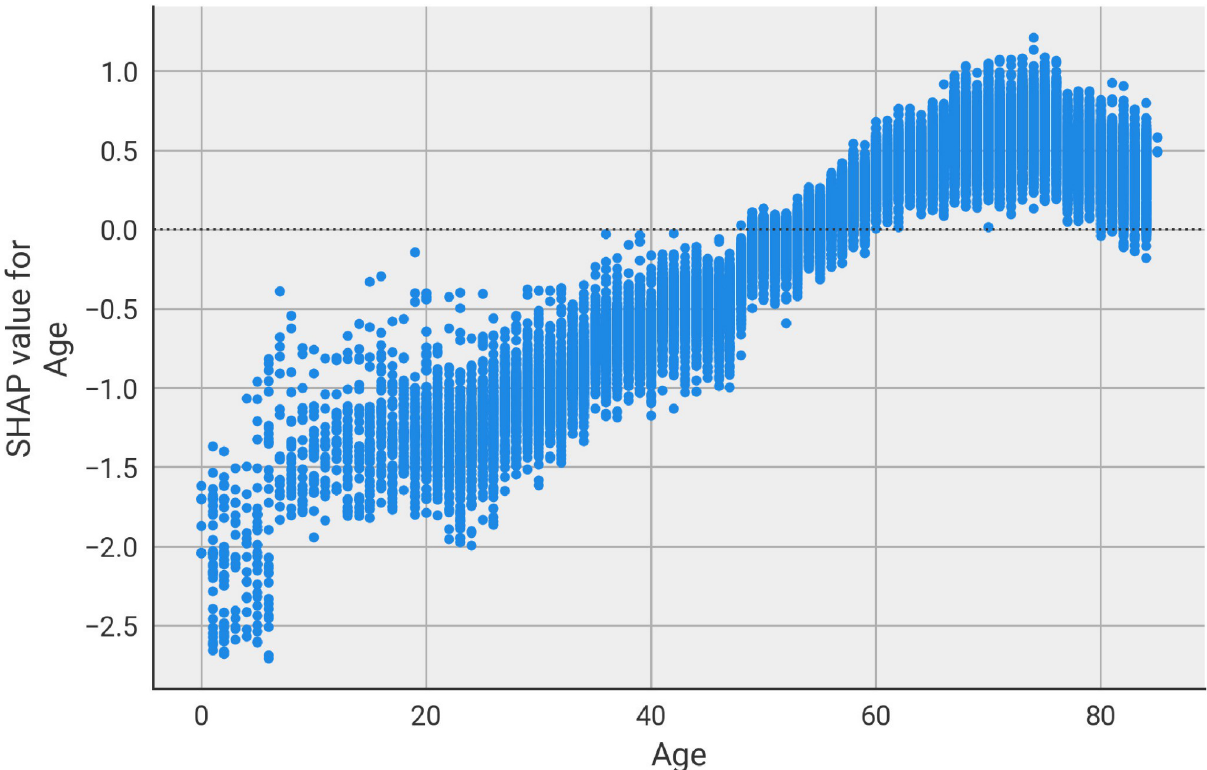
Fig 6. Age feature importance. Analysis of the importance of age towards prediction of ARDS in COVID-19 patients. Each dot represents a patient of the test set, indicating the SHAP value associated to their age.